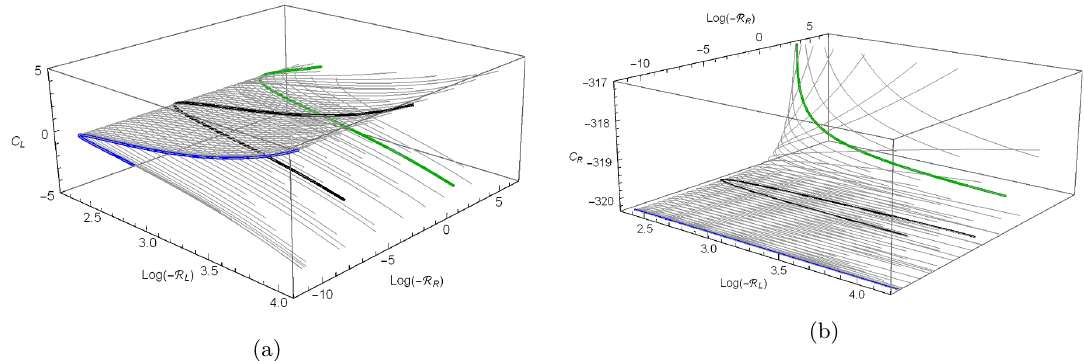
Figure 33 . As we change S 0 along a ϕ 0 = constant line in the red region in figure 28a we can read C L and C R in terms of the dimensionless curvatures. For example in the above figures, the black curve is at ϕ = 3 . 25 and the black one at ϕ = 4 0 0